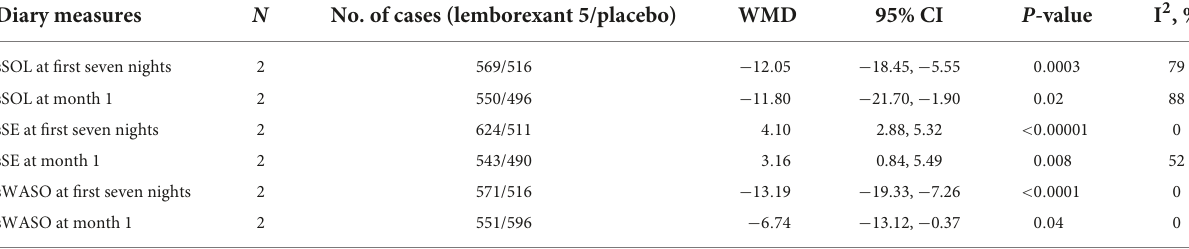
TABLE 5 The mean changes of efficacy outcome (diary measures) results from baseline in lemborexant 5 vs. placebo. Diary measures N No. of cases (lemborexant 5/placebo) WMD 95% CI P -value sSOL at first seven nights